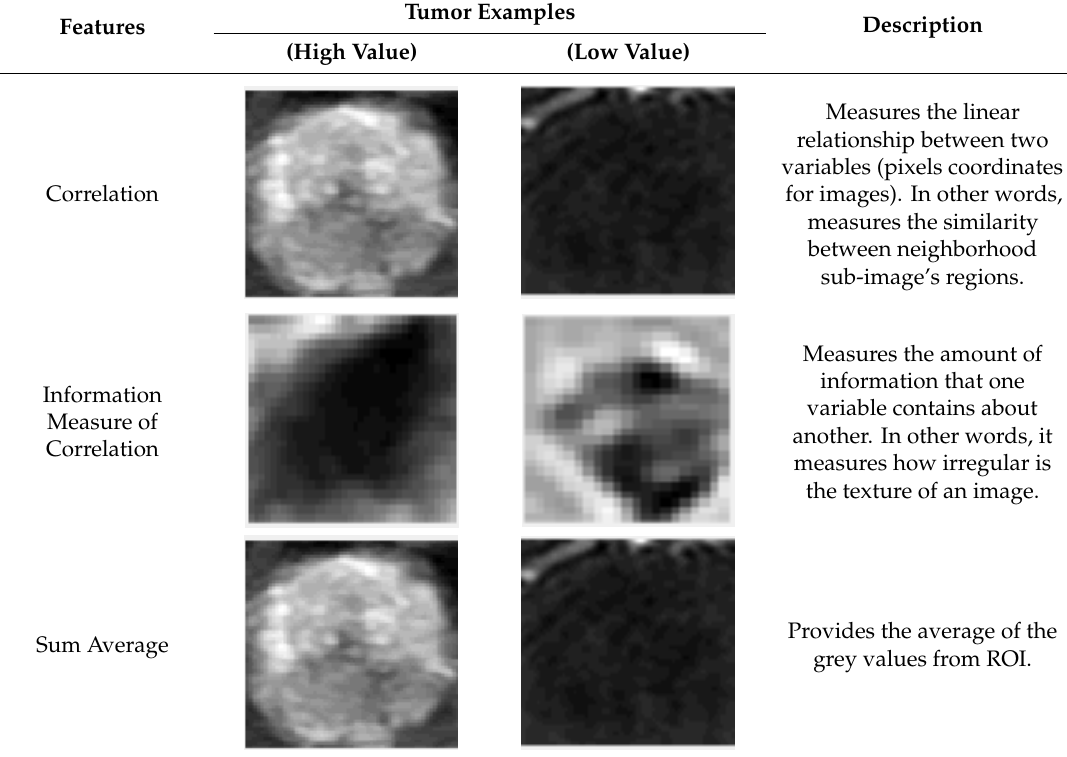
Table 3. Qualitative description of some of the most important identified features.